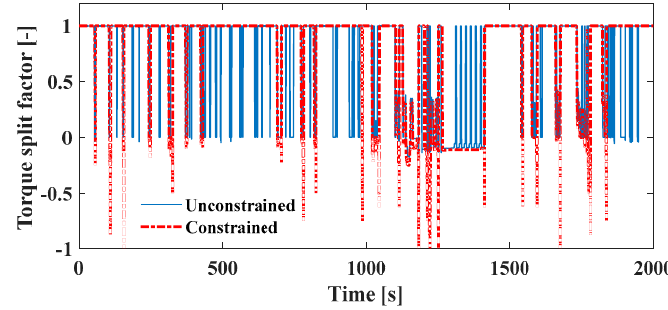
Figure 10. Comparison of the torque split factor.